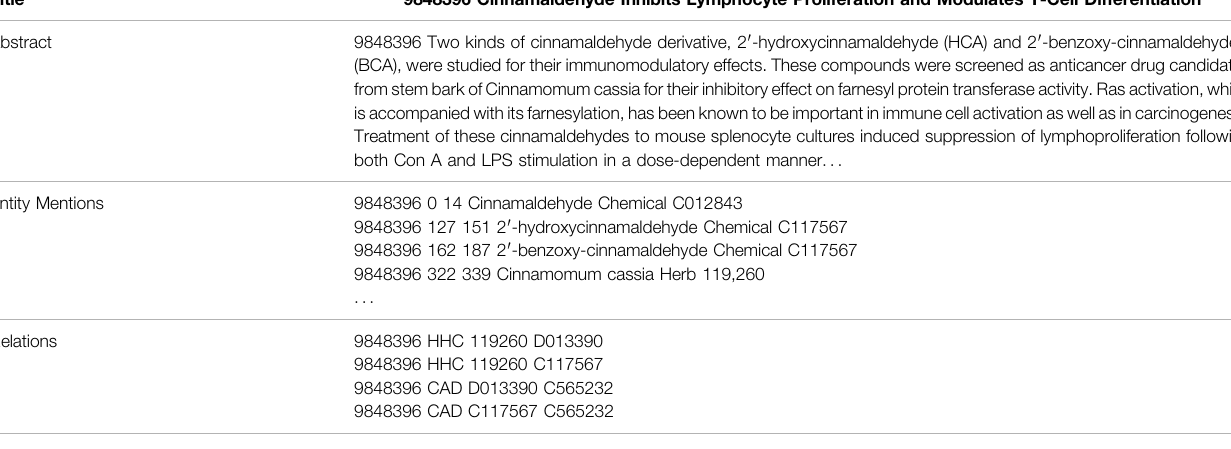
TABLE 1 | A sample with annotation in the herb RE dataset.